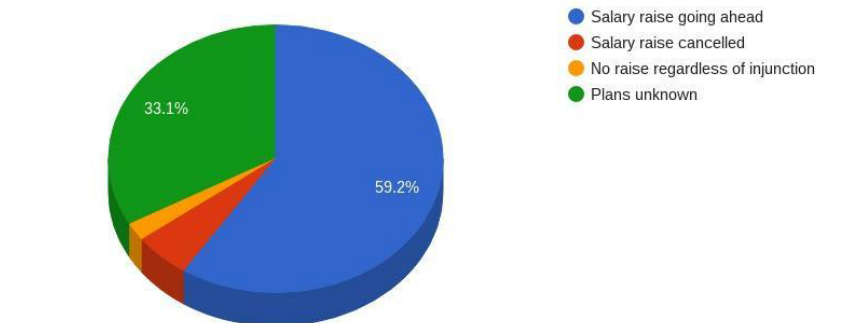
Figure 3. The effect of FLSA updates and institutional decisions on the Science, Engineering and Health postdoctoral workforce after an injunction against the updates was granted (data as of December 22nd 2016). Pie chart shows the percentage of the postdoctoral population at institutions implementing various plans for salary policies after an injunction against the FLSA updates was